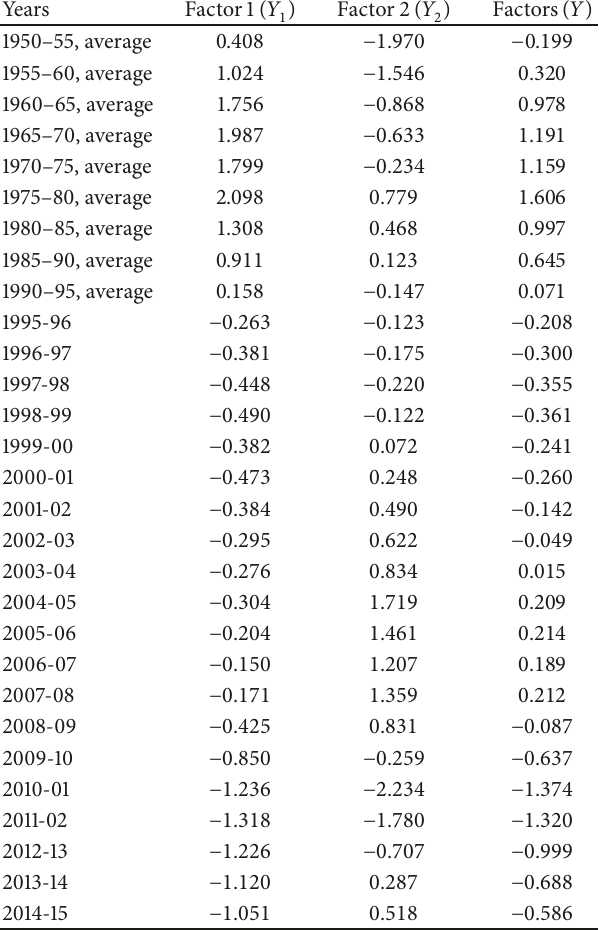
Table 8: Time series regression analysis for 1999–2015.